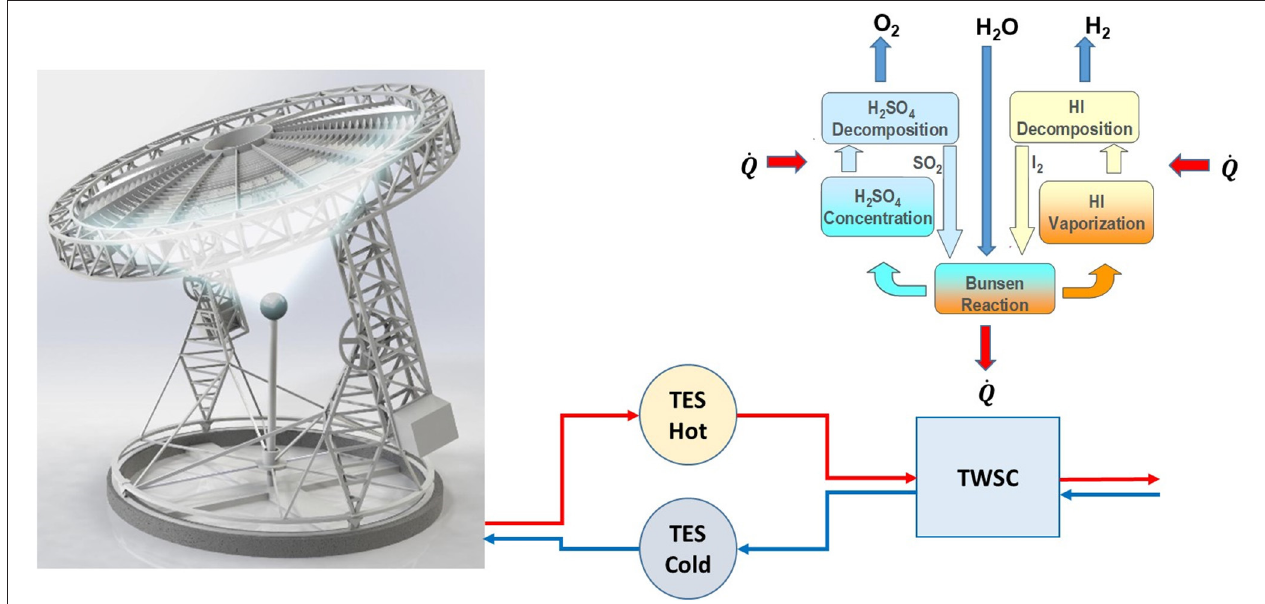
FIGURE 1 | Scheme of the upstream Ayman Solar Concentrator (ASC) with thermal energy storage (TES), plus the downstream thermochemical water-splitting cycle (TWSC).